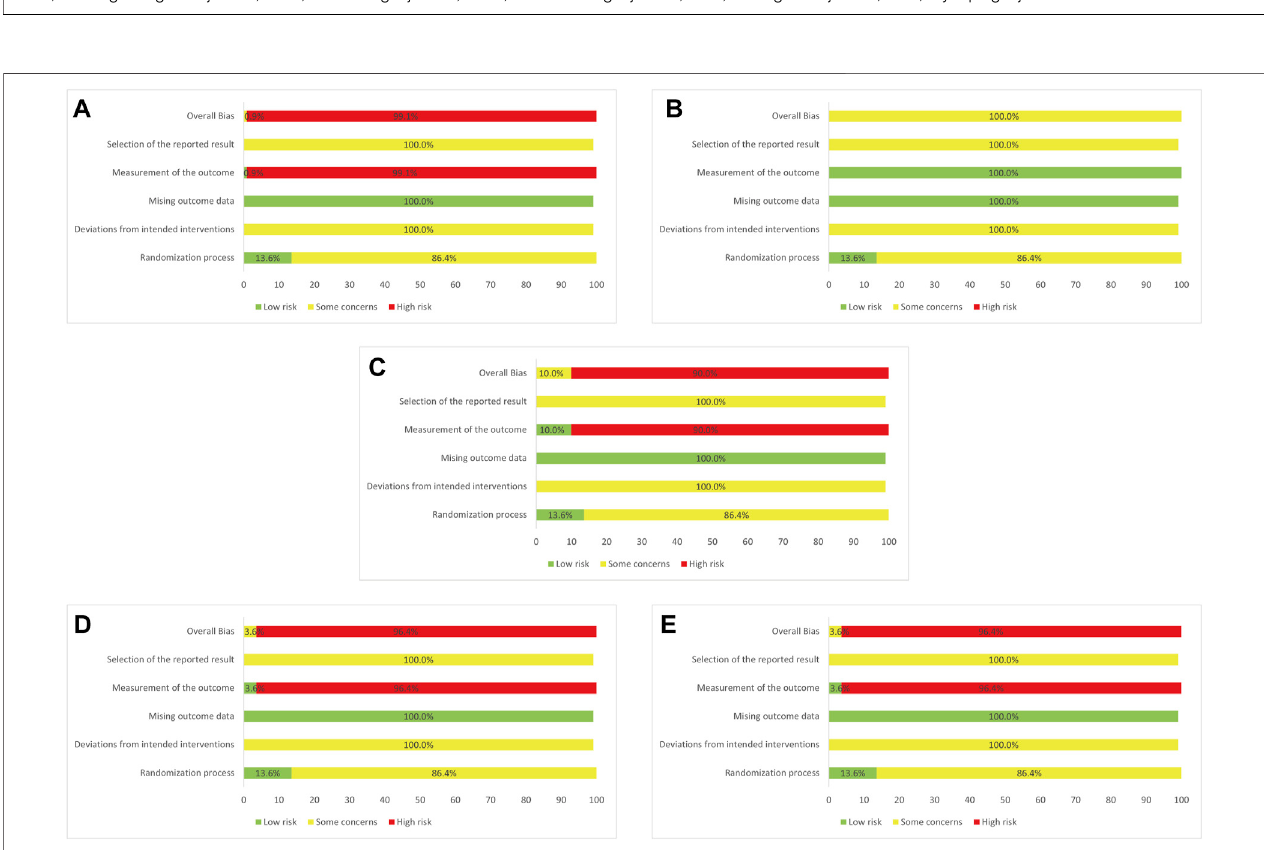
FIGURE 2 | Assessment of risk bias (A) Clinical effectiveness rate (B) Antipyretic time (C) Sore throat relief time (D) Red and swollen tonsils relief time (E) Tonsillar exudate relief time.